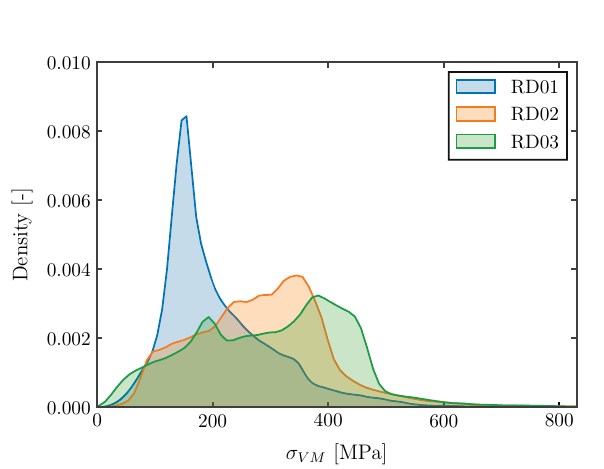
Figure 8. Probability distribution of Von Mises stress of the numerical models under same normalized macroscopic